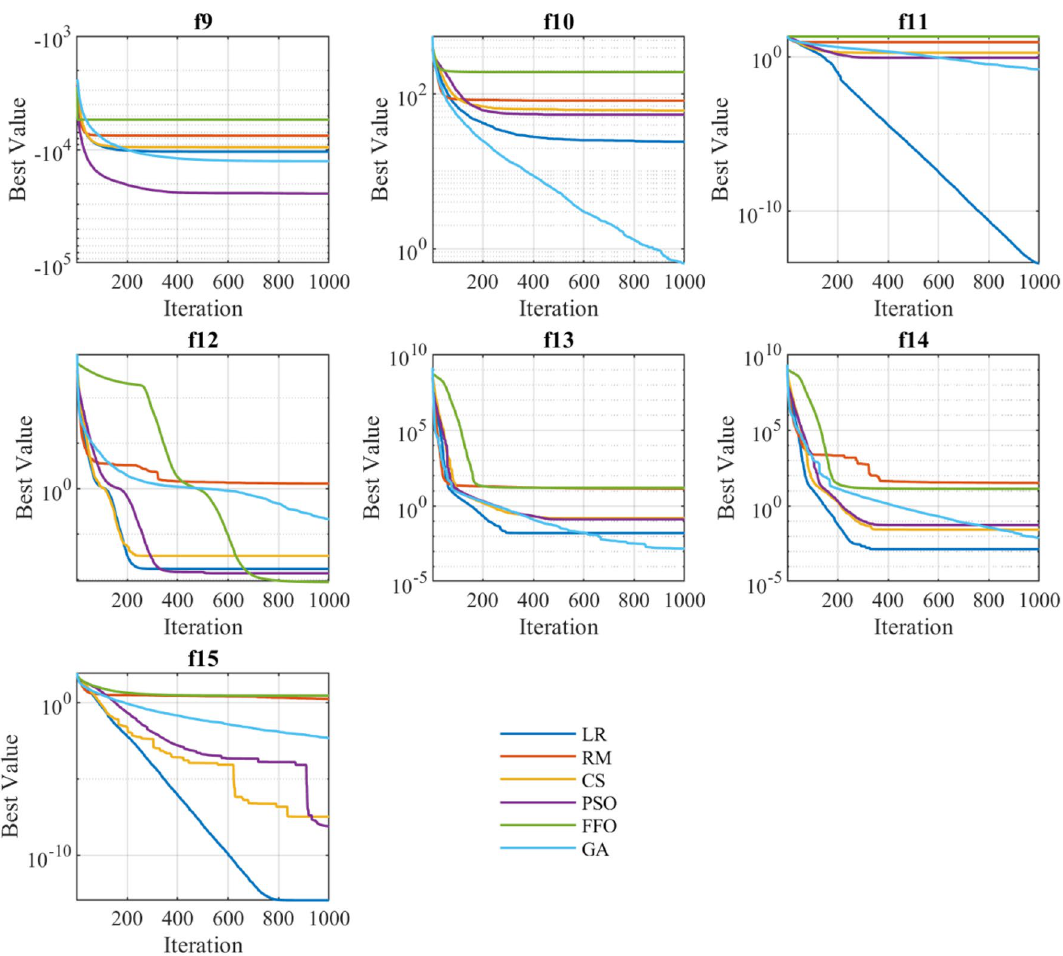
Figure 7. Convergence behaviour of the multimodal benchmark